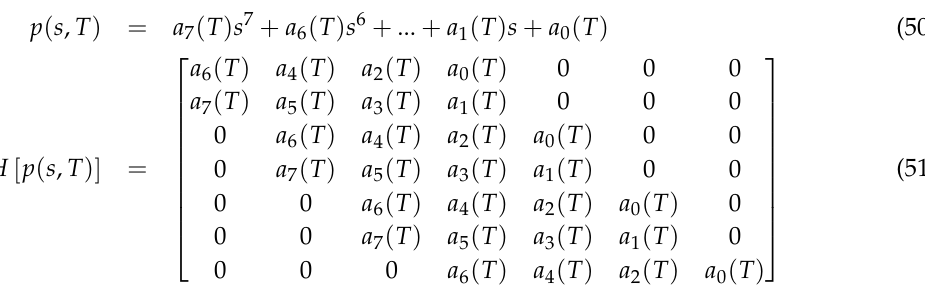
Figure 2. This platform consists of three identical modules whose elements are: a DC motor managed by a dual-core ARM Cortex-A9 embedded microcontroller system, with the ability to be programmed via WiFi, a Bluetooth transmitter, and a receiver (115,200 baud), as well as an encoder to measure motor speed, with a sampling frequency of 25 samples per second. Each motor has a load consisting of a wheel. The control algorithm was programmed using LabVIEW R (cid:13) . Before the tests, the WiFi communication was used to configure the controllers parameters, but, during the tests, it was only used to send the reference value from the computer to the leader controller. The gains k p = 0.07 and k cm = 1 were chosen to have an underdamped response. Note that while controllers 2 and 3 need one speed state information via Bluetooth, the controller 1, the leader, needs to have all speeds to calculate the center of mass. Approximate motor parameter values are shown in Table 1. It is important to note that, in this system, there may be several sources of uncertainty, namely motor parameters, measurement noise, and transmission delays. A schematic diagram of the multi-agent system is shown in Figure 2, and the experimental implementation is presented in Figure